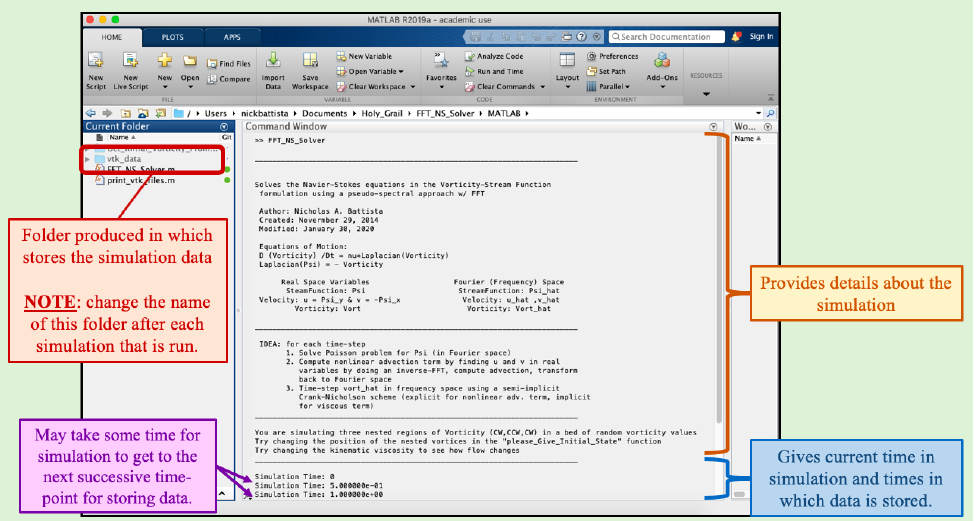
Figure 7. Showing the output on the screen when this example begins running. Note that the vtk_data folder is produced, in which stores the simulation data at predetermined